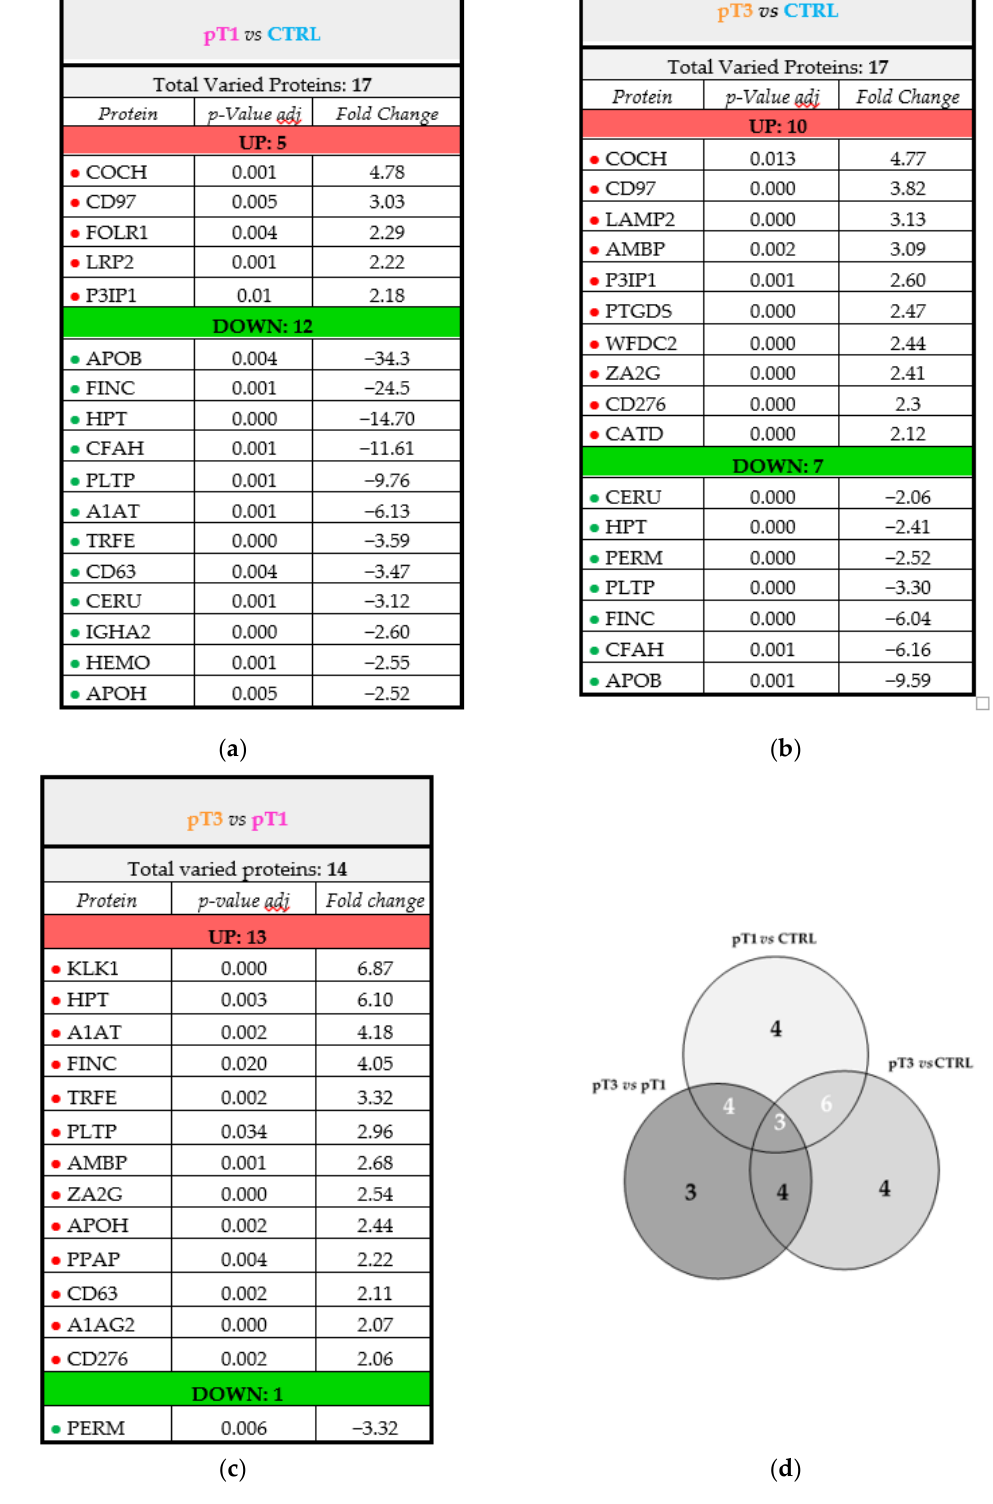
Figure 3. Lists of N -glycoproteins significantly varied in the comparisons: pT1 vs. CTRL ( a ), pT3 vs. CTRL ( b ), pT3 vs. Pt1 ( c ). The number of N -glycosylated proteins that significantly varied in each group represented by Venn diagram ( d ).